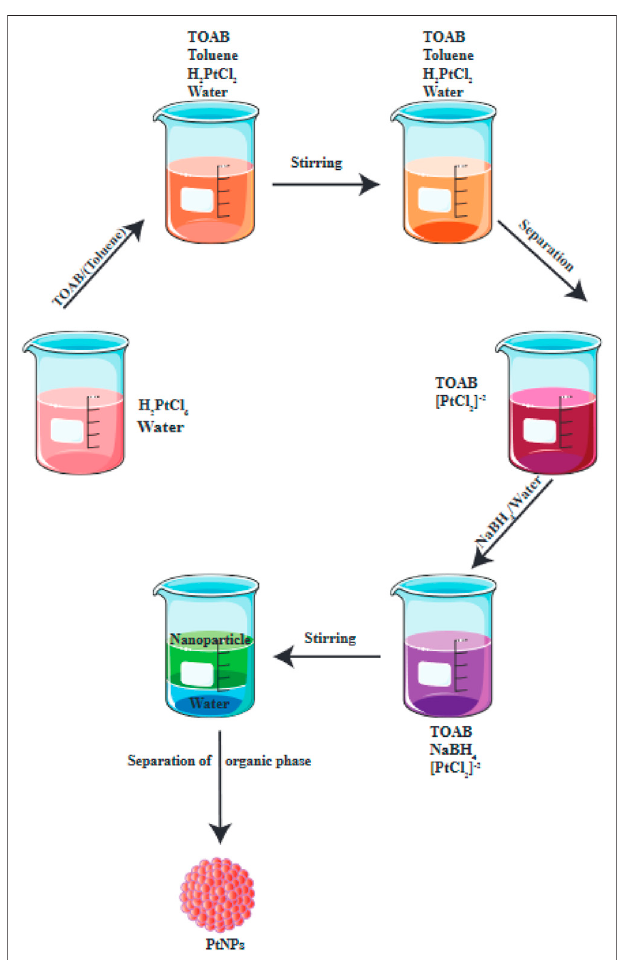
FIGURE2| ChemicalreductionisusedfortheproductionofPtNPs.This fi gure adapted from Jeyaraj et al. (2019).